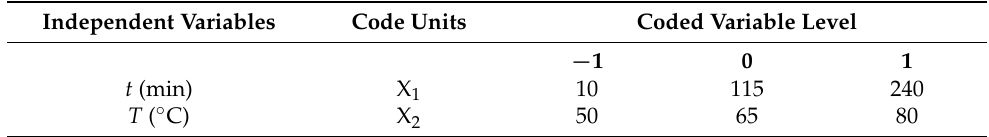
Table 1. Codified and actual variable levels used for the experimental design. Independent